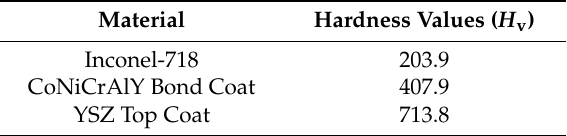
Table 2. Hardness values of the thermal barrier coating